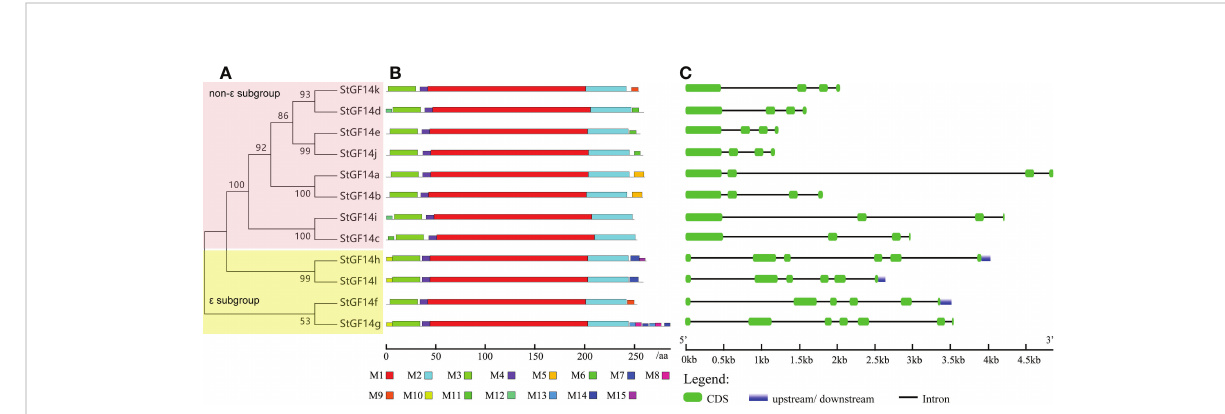
FIGURE 1 Phylogenetic relationships, conserved motifs distribution and gene structure of potato 14-3-3s. (A) Phylogenetic tree of twelve potato 14-3-3 proteins. (B) Distribution of conserved motifs within potato 14-3-3 protein sequences. The differently coloured boxes represent fi fteen different conserved motifs. (C) Exon/intron structures of potato 14-3-3s . The green boxes represent exons, the black lines represent introns, and the blue boxes indicates untranslated regions, and the lengths of exons can be inferred from the scale at the